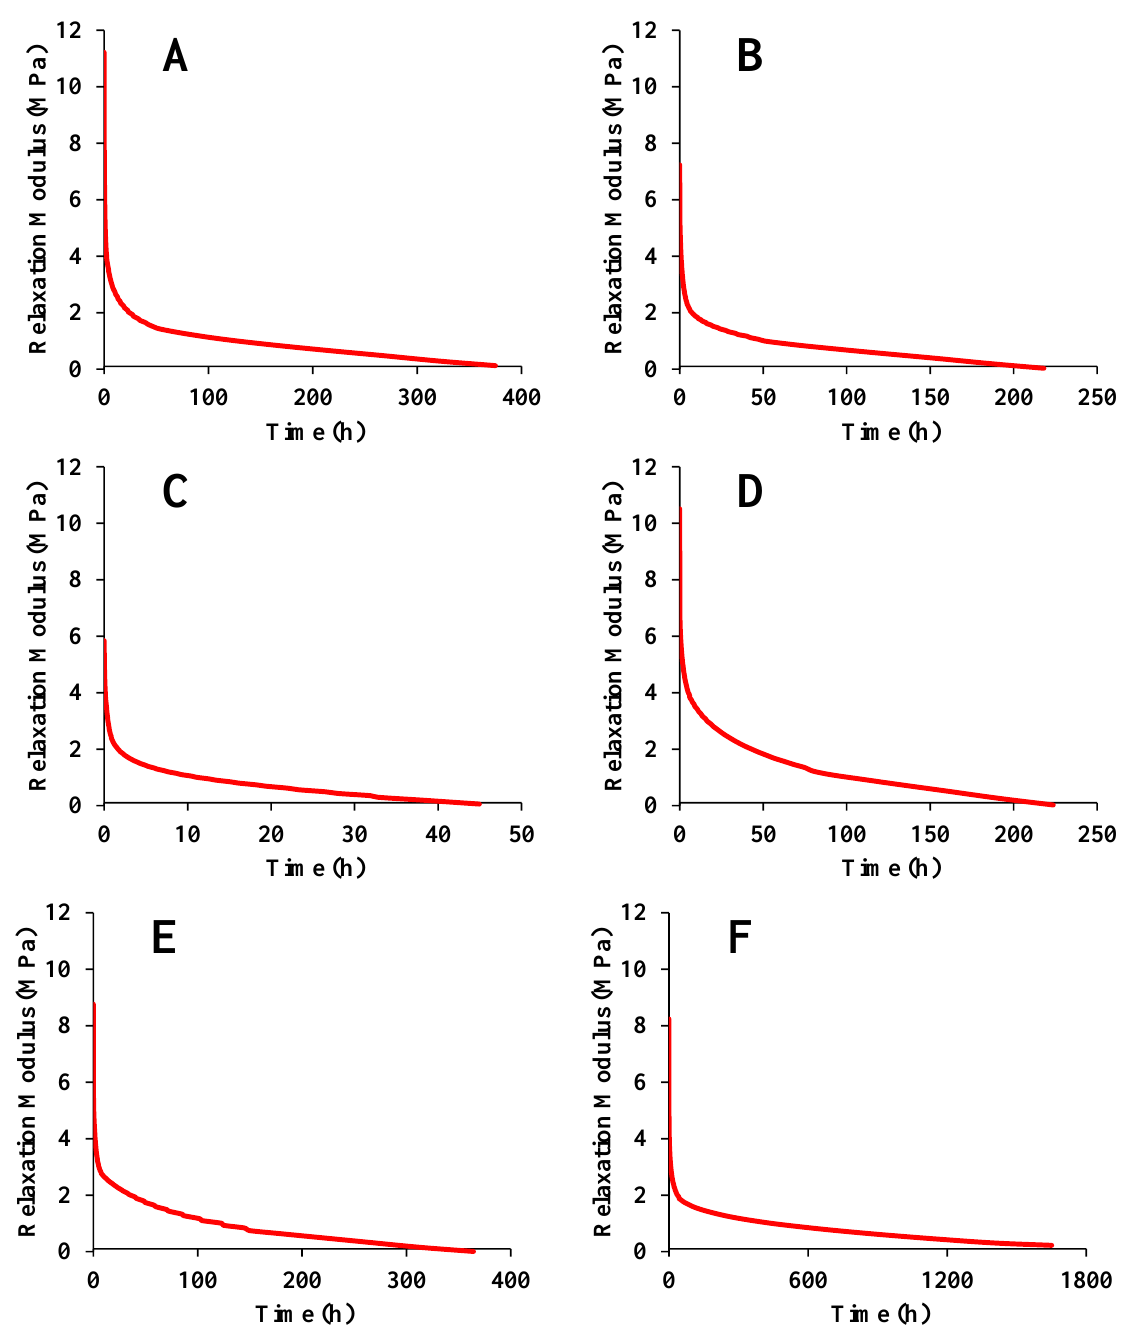
Figure 7. Time-temperature superposition (TTS) predicted stress relaxation for maize kernels dried under different conditions: ( A ) ND; ( B ) HVD 35 °C; ( C ) HVD 45 °C; ( D ) HVD 55 °C; ( E ) HVD 65 °C; ( F ) HVD 75 °C.